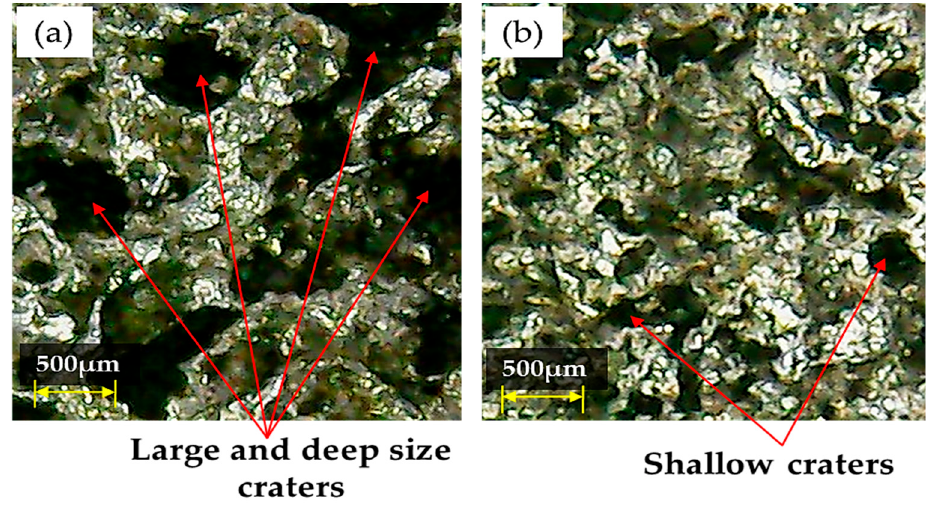
Figure 15. Micrographs demonstrating different types of craters formed on the workpiece surface with: ( a ) Al-electrode; ( b ) Cu-electrode.